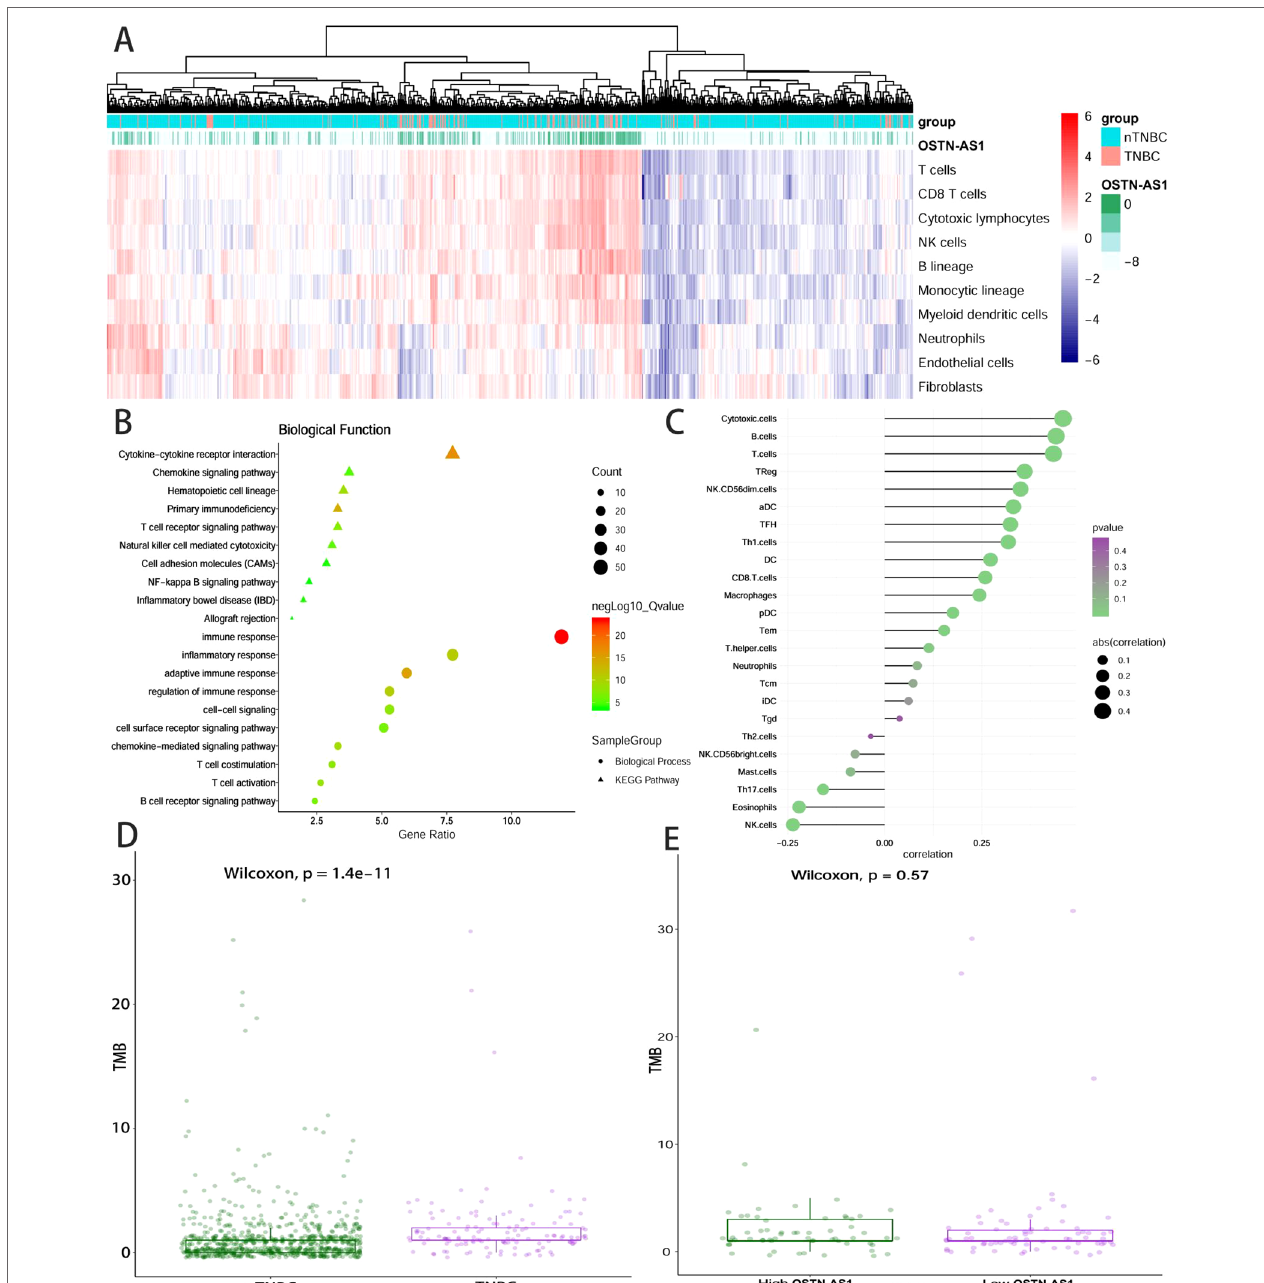
FIGURE 4 | OSTN-AS1 was associated with immune response. (A) The MCP counter algorithm was utilized to analyze the degree of infiltration of immune cells with changing OSTN-AS1 expression. (B) Biological process and KEGG pathway analysis of differentially expressed genes between OSTN-AS1 high expression group and OSTN-AS1 low expression group. (C) The exhibition of correlation coefficient between the expression of OSTN-AS1 and several immune cell infiltration level calculated by ssGSEA analysis. (D) TMB levels of different subgroups in breast cancer. (E) TMB levels in TNBC according to the